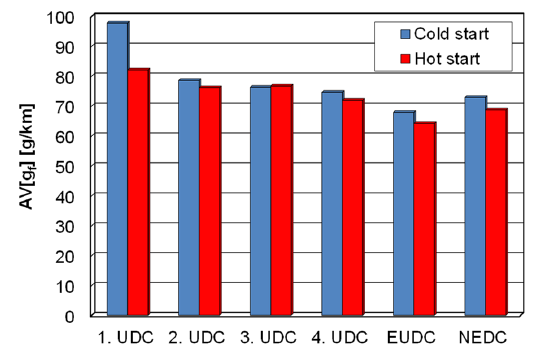
Figure 15. Average fuel mass consumption (AV[g f ]) in four parts as well as in the NEDC test for cold and hot starts.